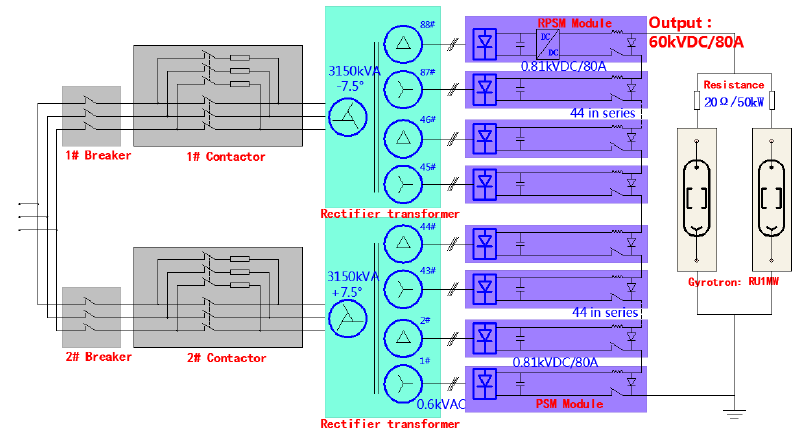
Fig. 1. The topology of HVPS for 140GHz ECRH system on